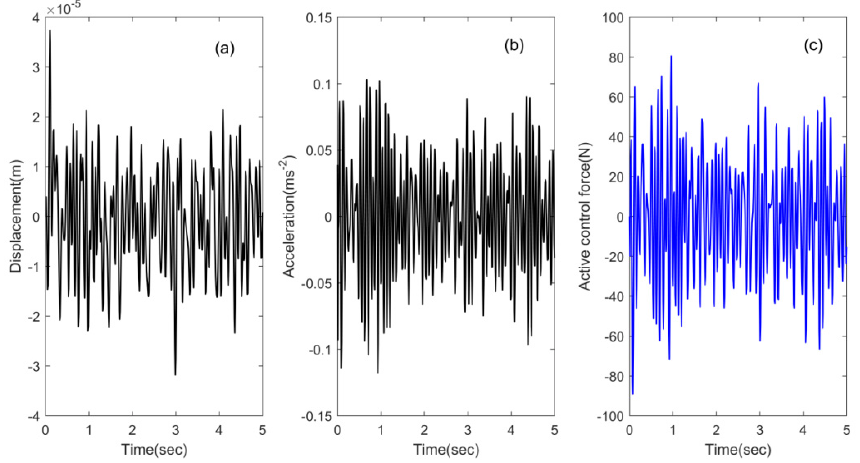
Figure 3. The displacement and acceleration responses ( a , b ), and ( c ) control forces (6) of the hybrid isolator with quasi-zerostiffness (QZS) for case (i).